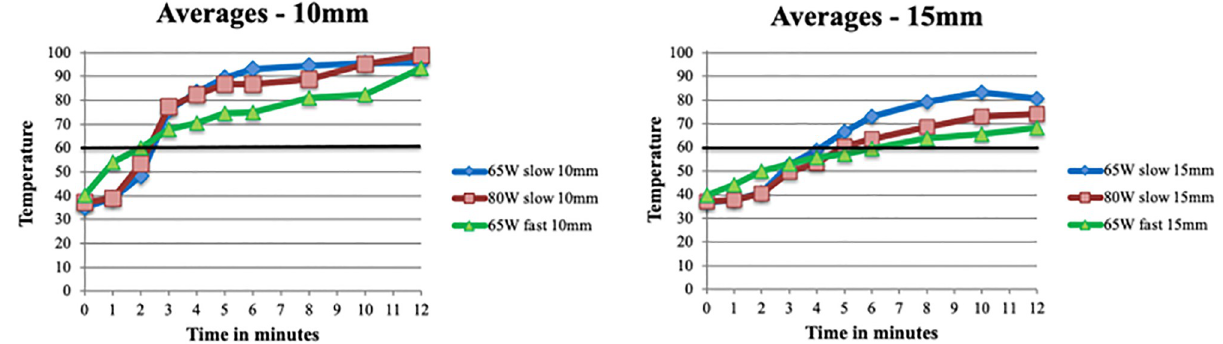
Fig 4. Average temperatures at different distances from the needle for MWA in ex-vivo sheep femur. A. Averages at 10mm for 65W slow- and fast cooking and 80W slow-cooking. B. Averages at 15mm for 65W slow- and fast cooking and 80W slow-cooking. Black lines depict the aimed temperature of 60˚C.